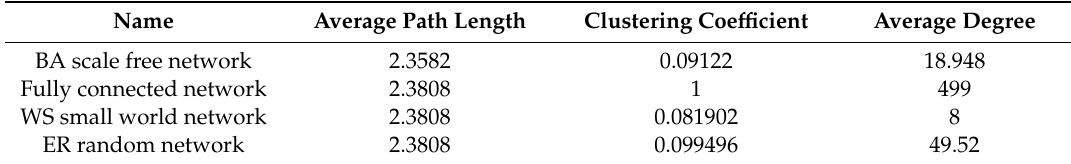
Table 3. Di ff erent network topology